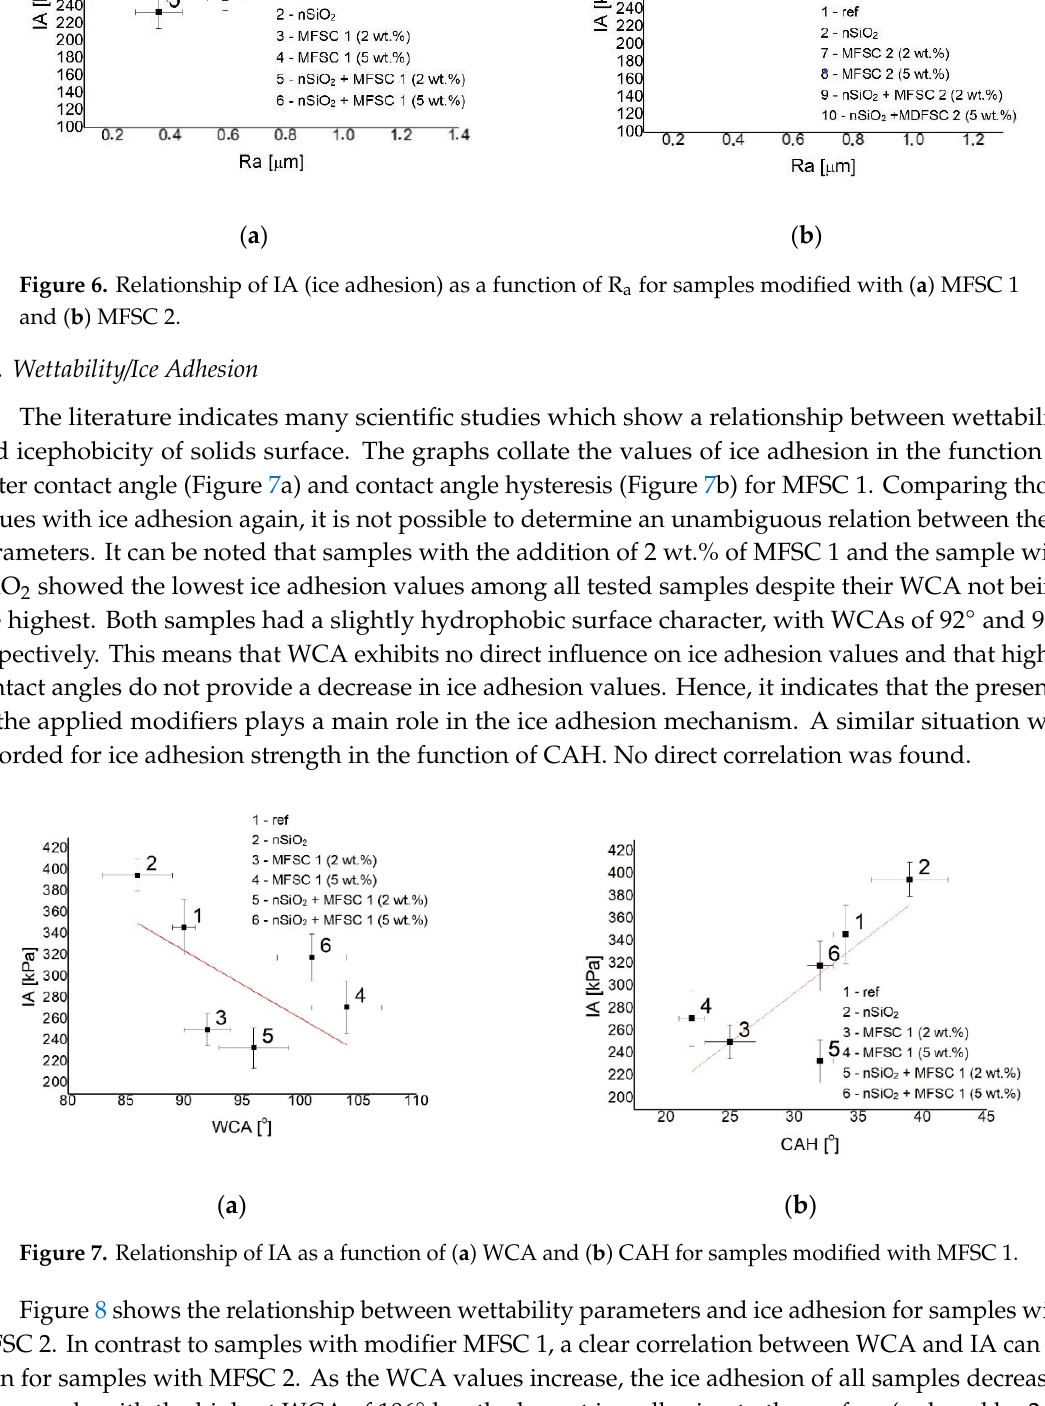
( b ) Figure 8. Relationship of IA as a function of ( a ) WCA and ( b ) CAH for samples modified with MFSC 2.